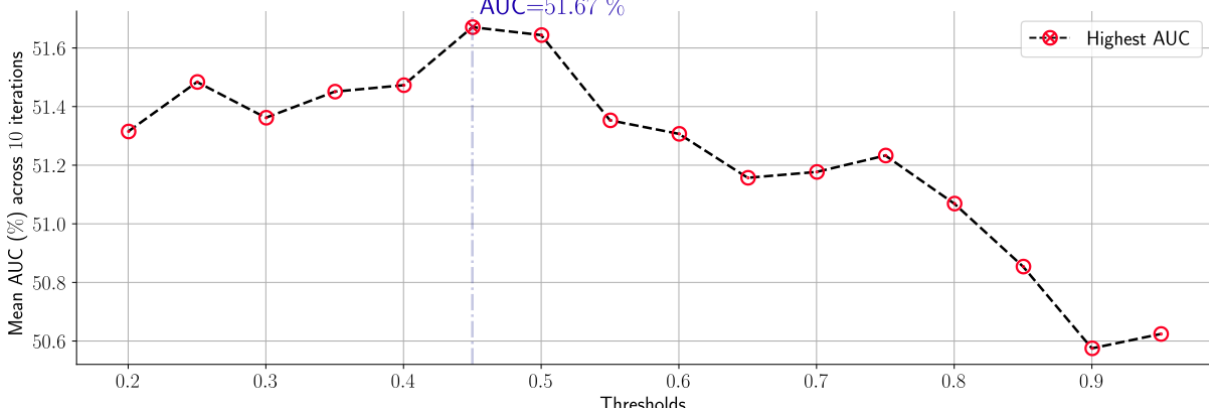
Figure 8. Optimal threshold selection corresponding to the 6th histogram value. The overall mean area under the curve was computed across the 10 iterations and plotted against different threshold values. AUC: area under the